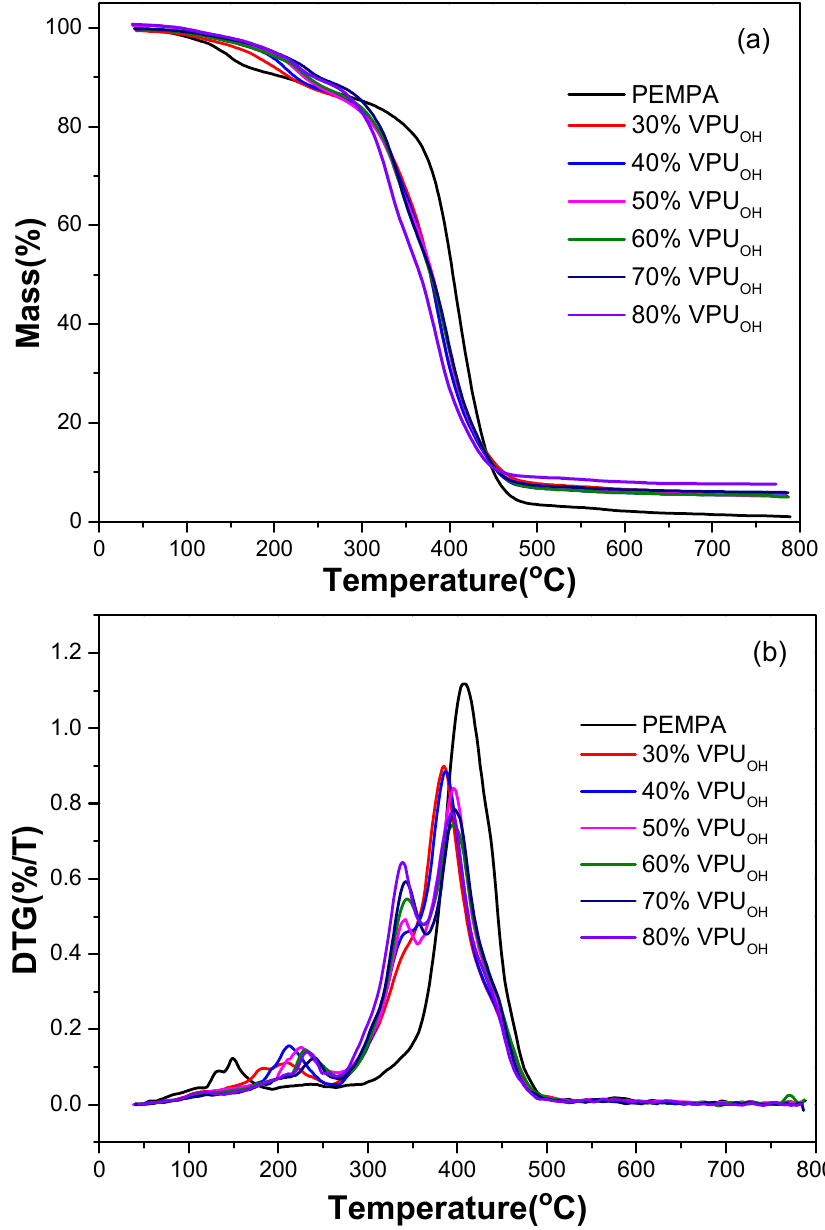
Figure 4. ( a ) TGA and ( b ) DTG curves of PEMPA and the VPU OH series with different HDI con-